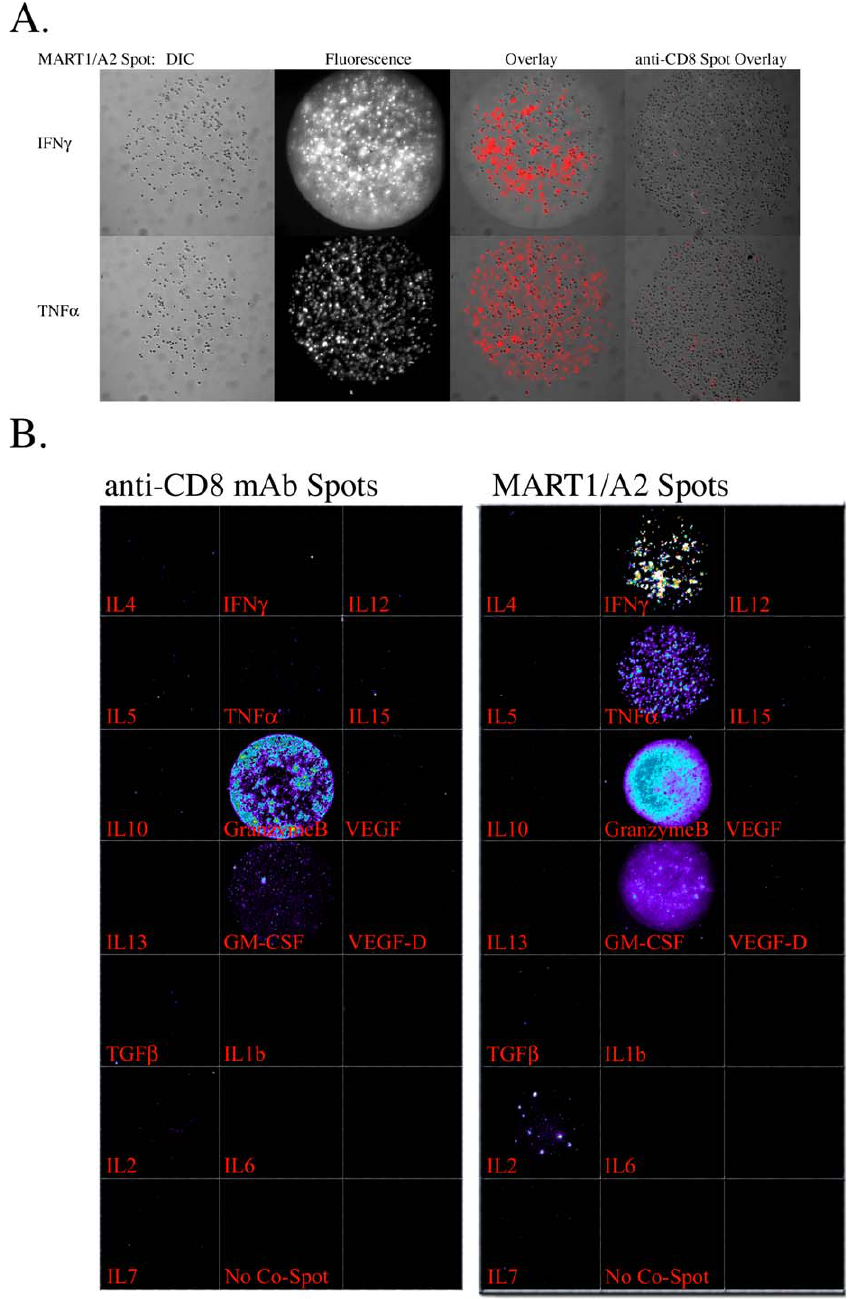
Figure 3. Profiling T Cell